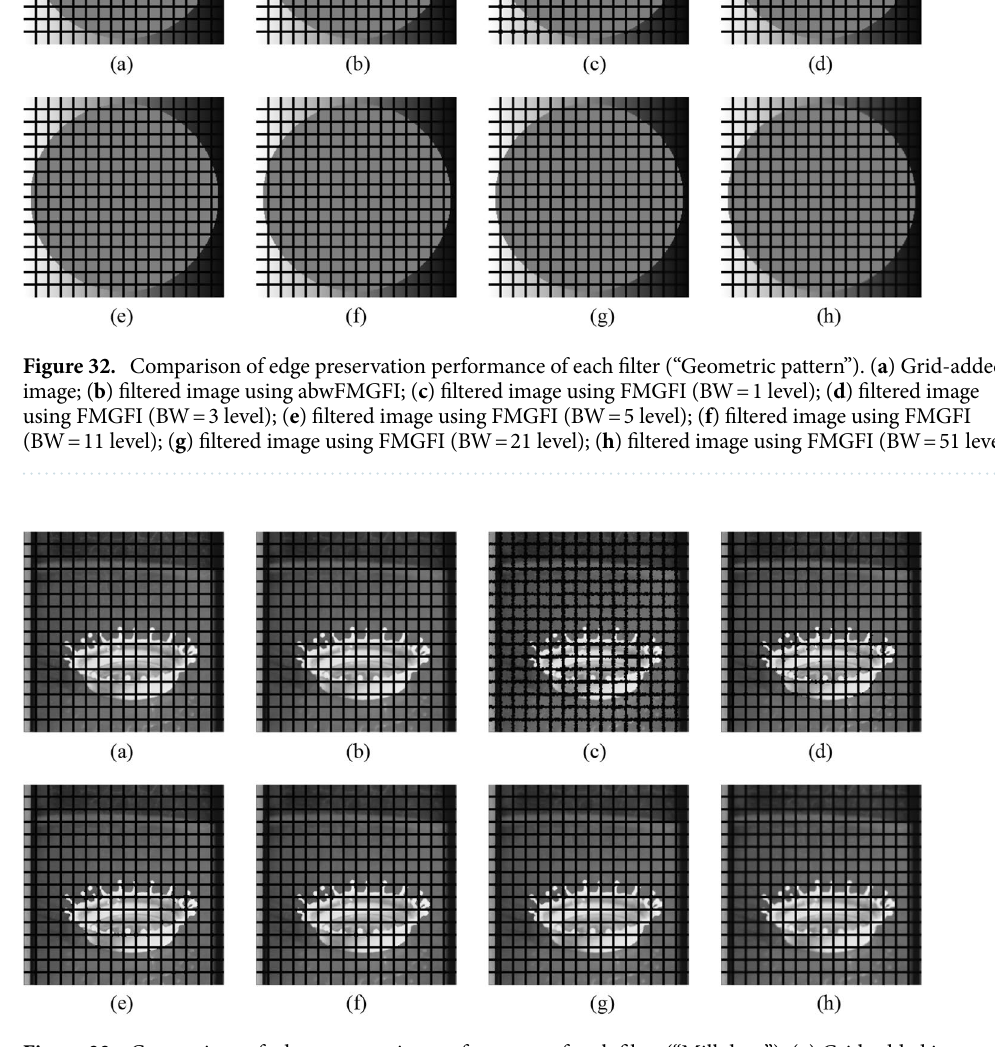
Figure 33. Comparison of edge preservation performance of each filter (“Milkdrop”). ( a ) Grid-added image; ( b ) filtered image using abwFMGFI; ( c ) filtered image using FMGFI (BW = 1 level); ( d ) filtered image using FMGFI (BW = 3 level); ( e ) filtered image using FMGFI (BW = 5 level); ( f ) filtered image using FMGFI (BW = 11 level); ( g ) filtered image using FMGFI (BW = 21 level); ( h ) filtered image using FMGFI (BW = 51